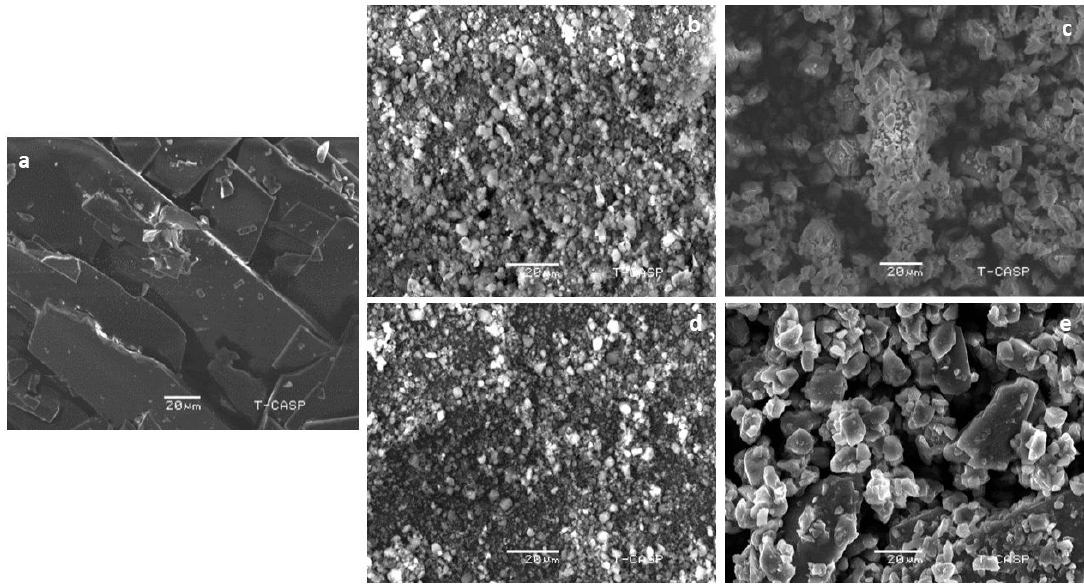
Figure 4. SEM images of ( a ) flurbiprofen, ( b ) S1, ( c ) S6, ( d ) S7 and ( e ) S12.